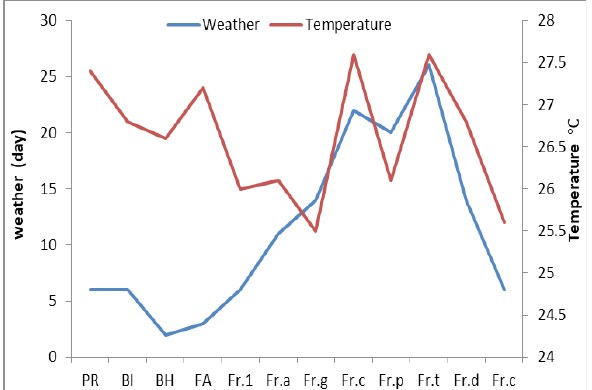
Figure 5. Fluctuation from initial primordia into fruit har- vested as a function of temperature in lemon (Citrus auran- tifolia Swingle).